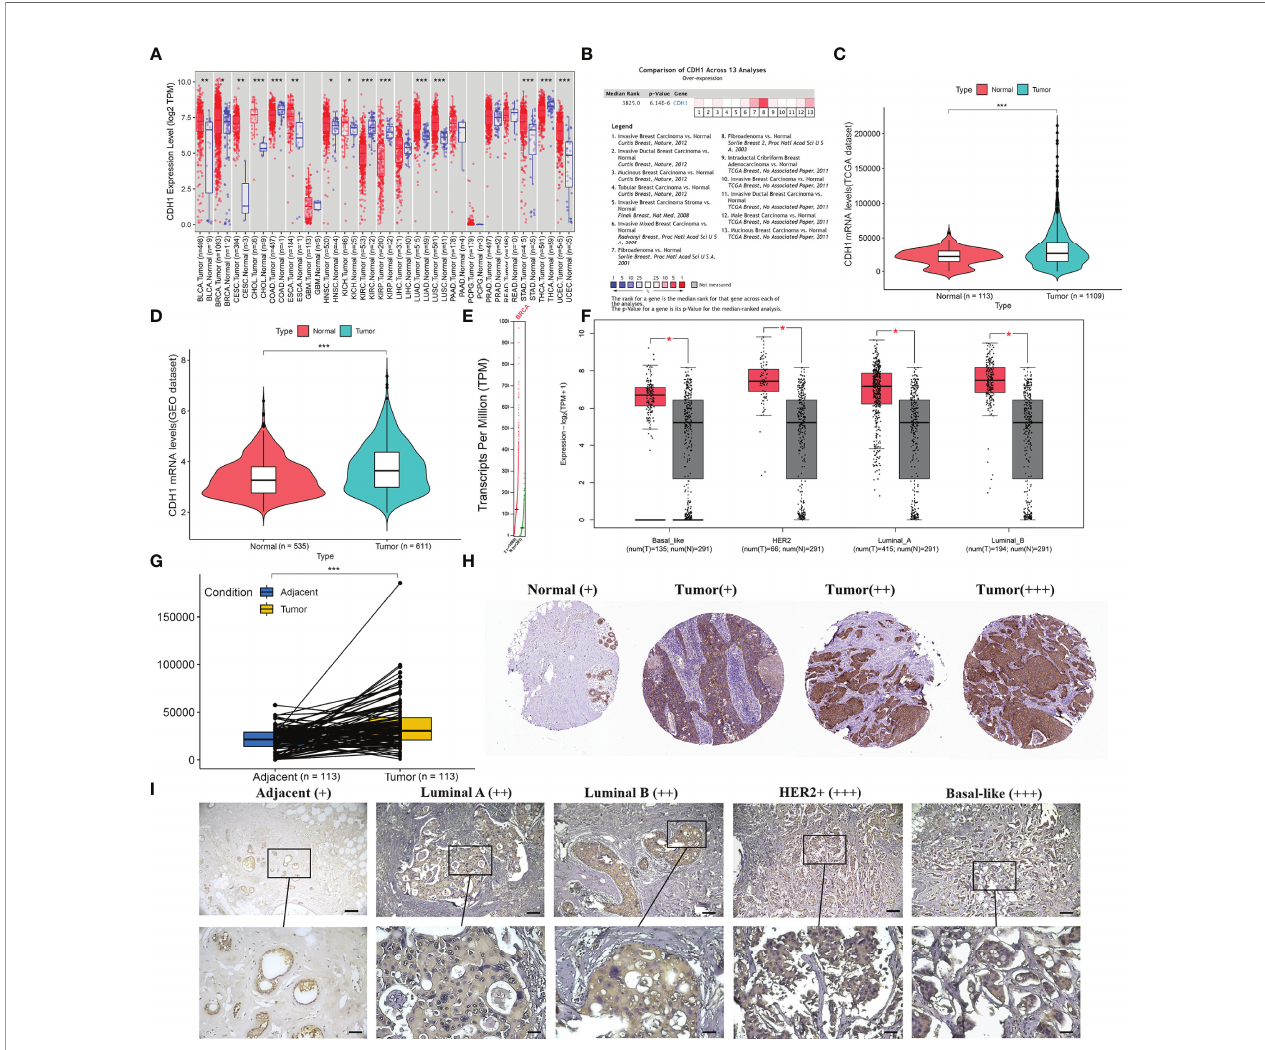
FIGURE 1 | CDH1 expression is increased in human breast cancer tissues. (A) CDH1 gene expression pro fi le across 21 types of tumor samples and normal tissues from TIMER2.0 analysis. (B) Oncomine analysis of CDH1 expression in human cancers. (C-E) CDH1 expression in TCGA, GEO, and TIMER2.0 is higher in BC tissues than in normal tissues. (F) GEPIA database analysis of CDH1 expression was increased in all subtypes of BC tissues compared to normal tissue. (G) TCGA database shows higher levels of CDH1 expression in BC tissues than in pericarcinomatous tissues. (H) HPA database shows higher expression of E-cadherin in BC tissues than in normal tissues. (I) Representative immunohistochemical staining of E-cadherin in multiple BC subtypes. Scale bar = 60 m m (upper panels), Scale bar = 30 m m (lower panels). * P < 0.05; ** P < 0.01; *** P <